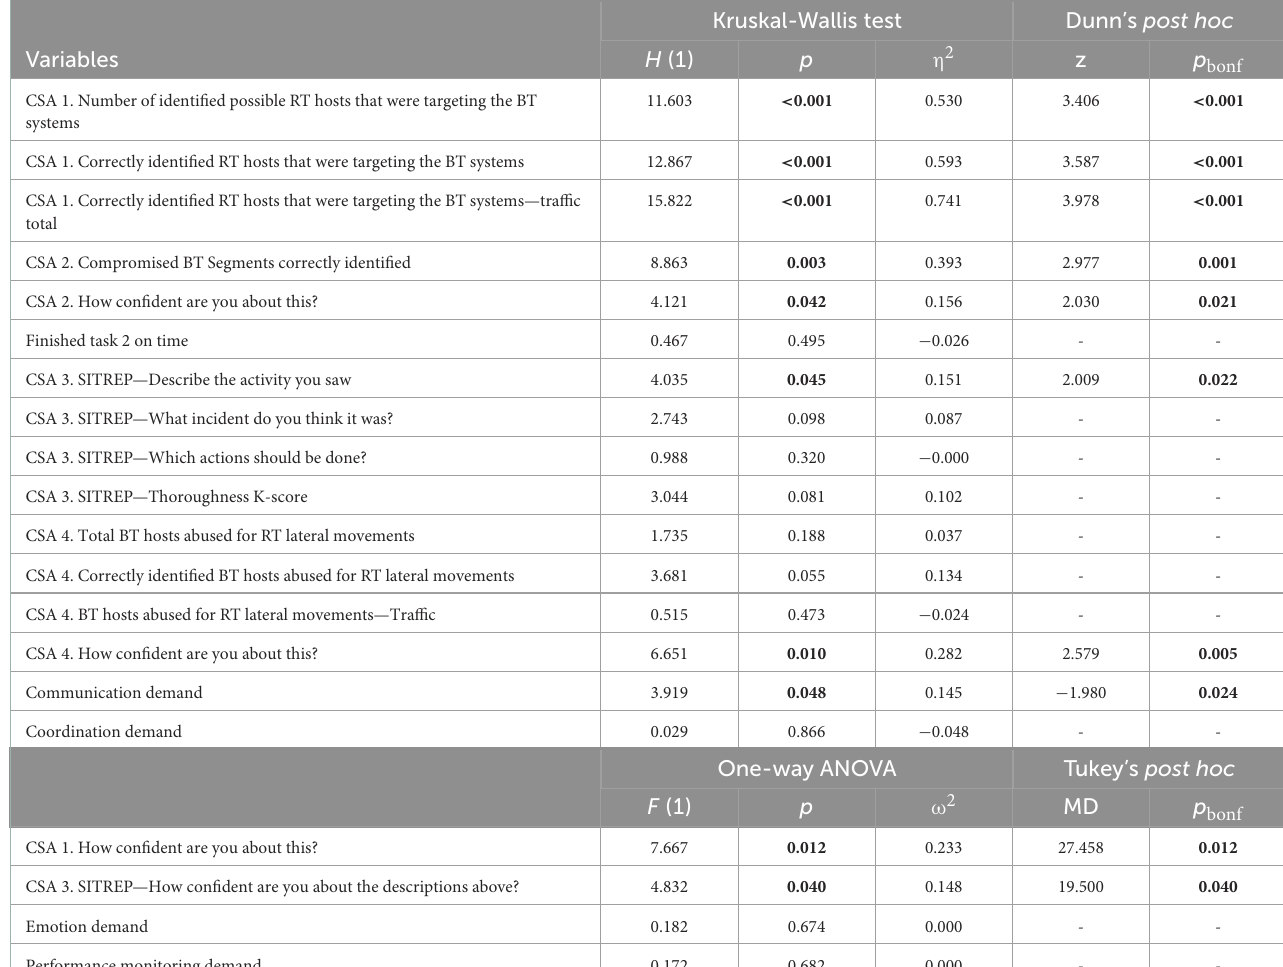
TABLE 3 Comparison of task two and task three results between VDE and Arkime ( N =